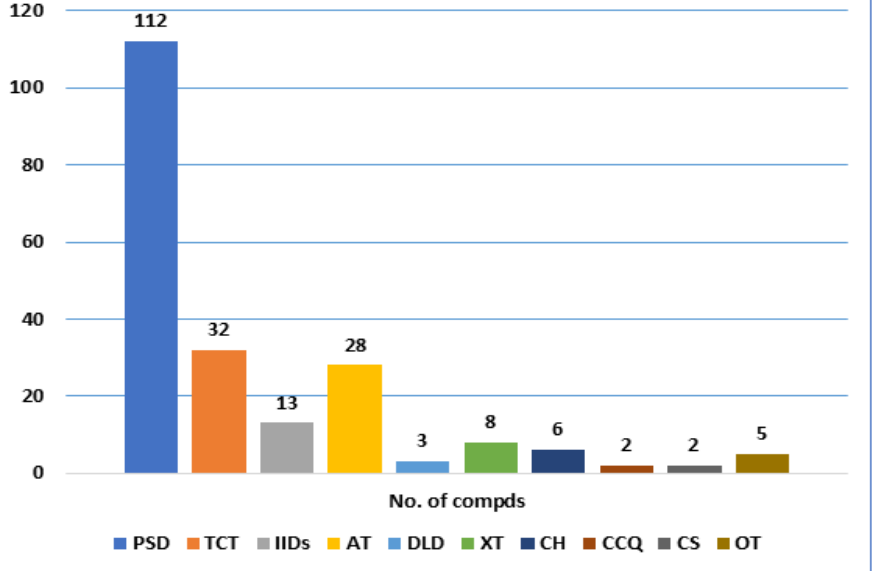
Figure 28. Different classes of metabolites reported from S. chartarum. PSD: Phenylspiro-